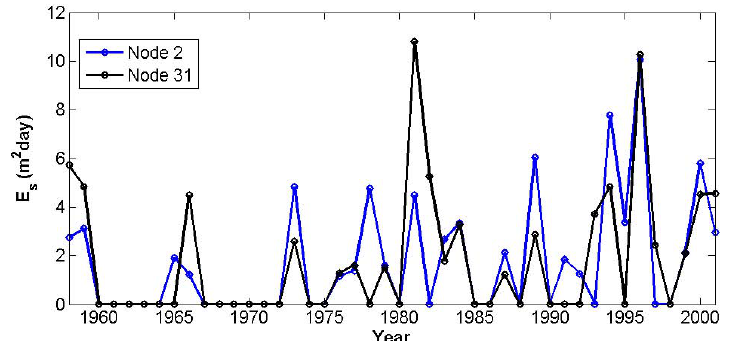
Fig. 8. Two examples of annual mean E s temporal evolution for storm events coming from S.